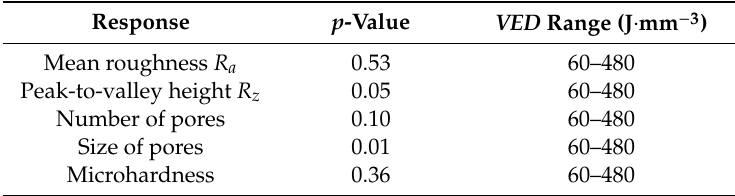
Table 5. Results of normality test and related range of